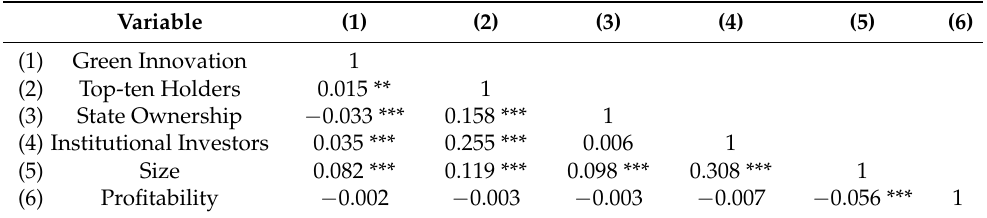
Table 4. Correlation coefficient test results of main variables.